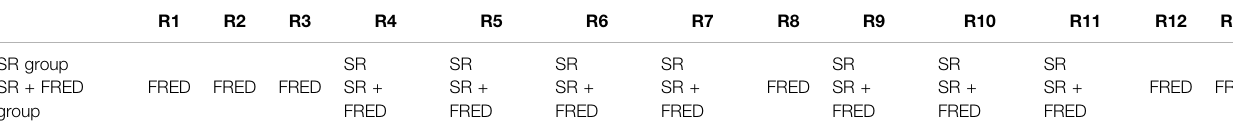
TABLE 1 | Reconditioning programs for SR group ( N = 12) and SR + FRED group ( N =